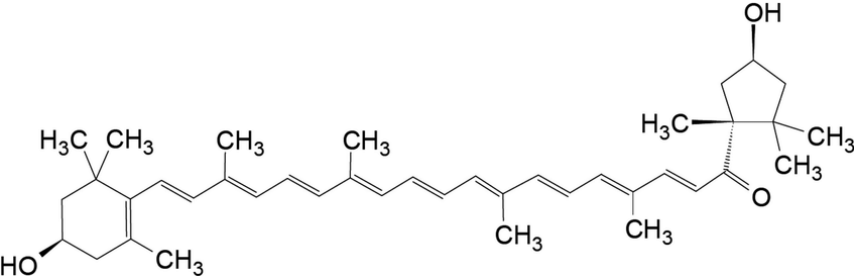
Figure 1. Structure of capsanthin, major carotenoids in red paprika Capsicum annuum L.